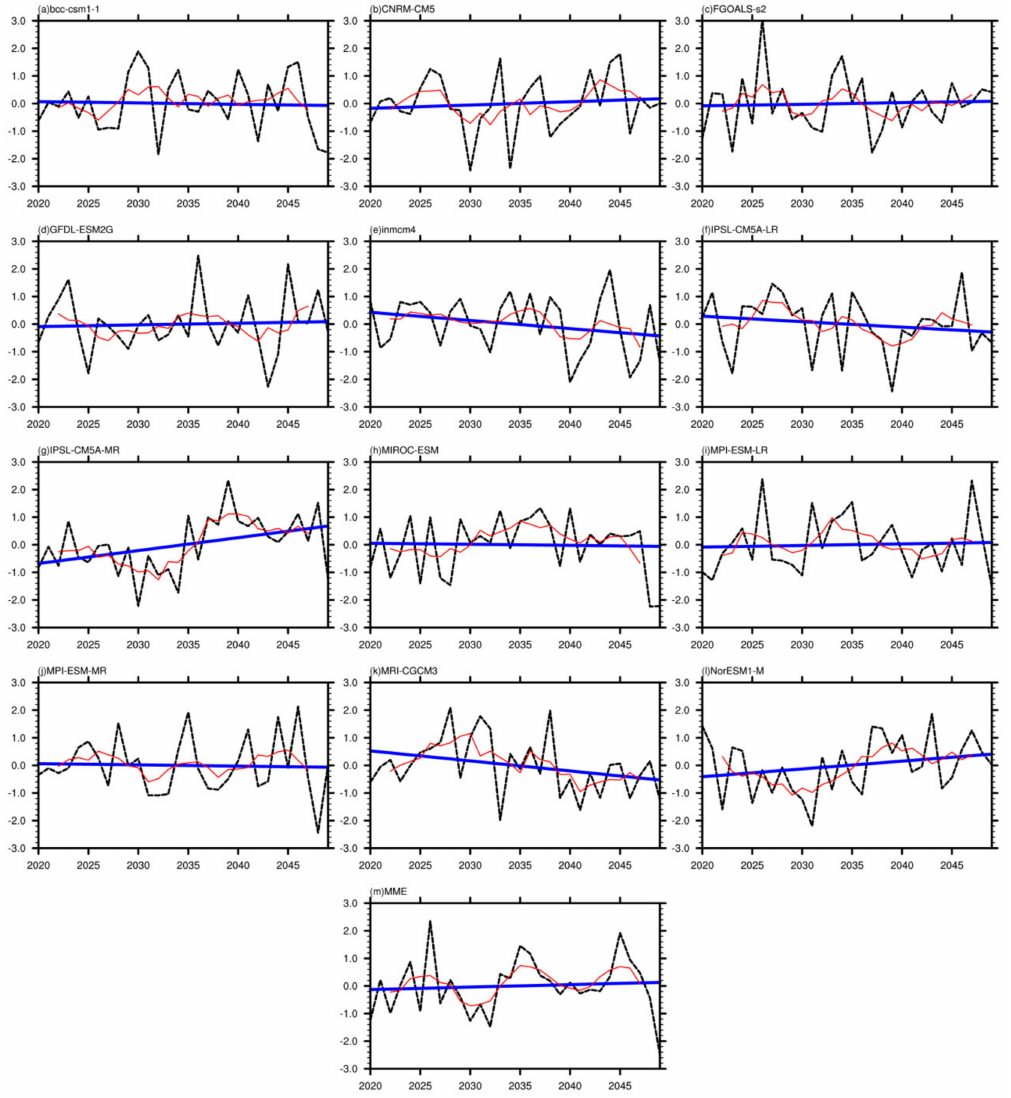
Figure 5. Trends of precipitation in the flood season from 2020–2049 for 12 models and MME, black line: Regional average in Dongting Lake Basin; red line: Five-year moving average; blue line: linear